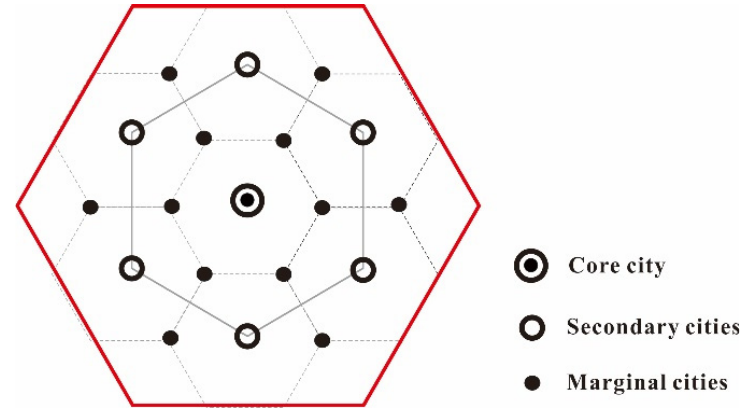
Figure 4. The central place system.